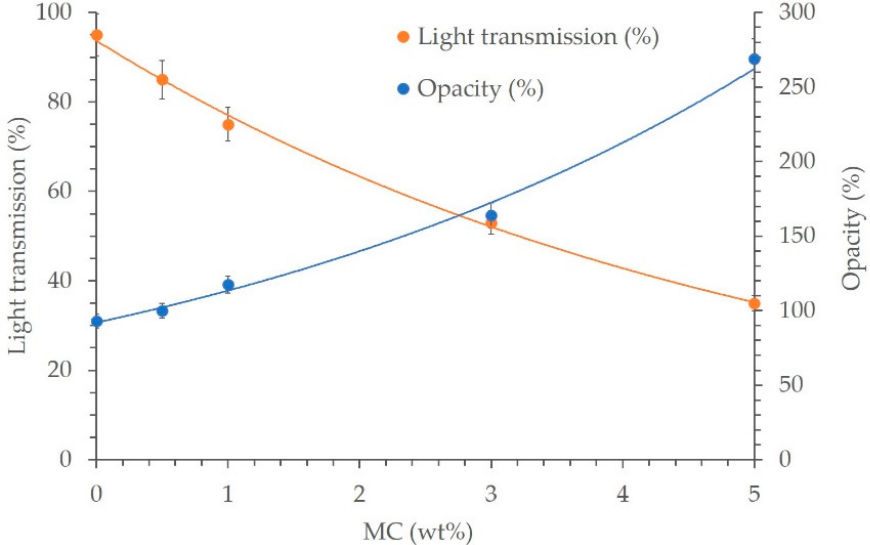
Figure 8. Light transmission and opacity of various LDPE/MC composite films.